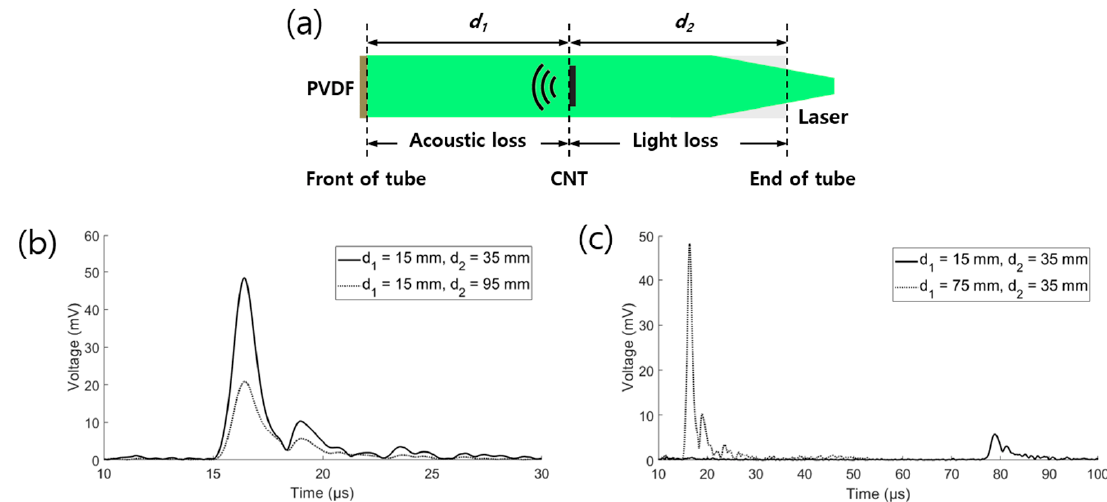
Figure 6. ( a ) Sensor structure used in the experiment; Enveloped received data for the same ( b ) d 1 and ( c ) d 2